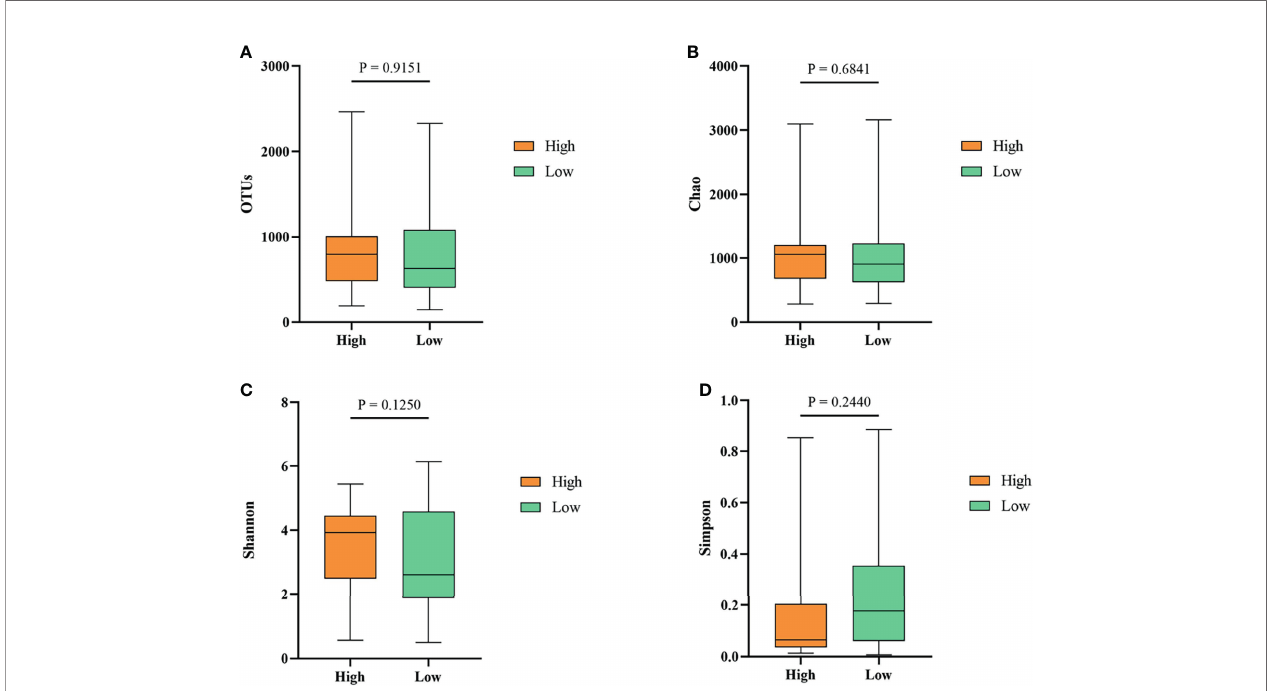
FIGURE 4 | The a -diversity of the ileal microbiota of Muscovy ducks in the high and low groups. The OTUs (A) , Chao (B) , Shannon (C) , and Simpson (D) were determined to elucidate the diversity and richness of the microbial community in the ileum of the Muscovy ducks in the high and low groups. Data were expressed as mean ± SD (n = 40) and analyzed by unpaired two-tailed Students ’